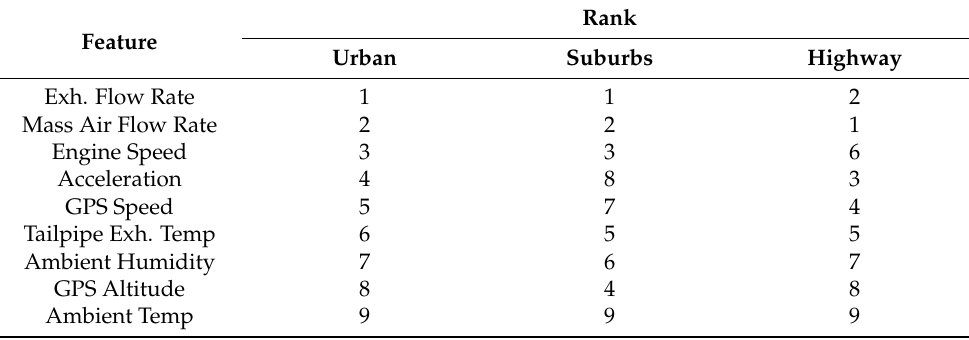
Table 8. Feature importance rank of urban, suburbs, and highway CO 2 model. Feature